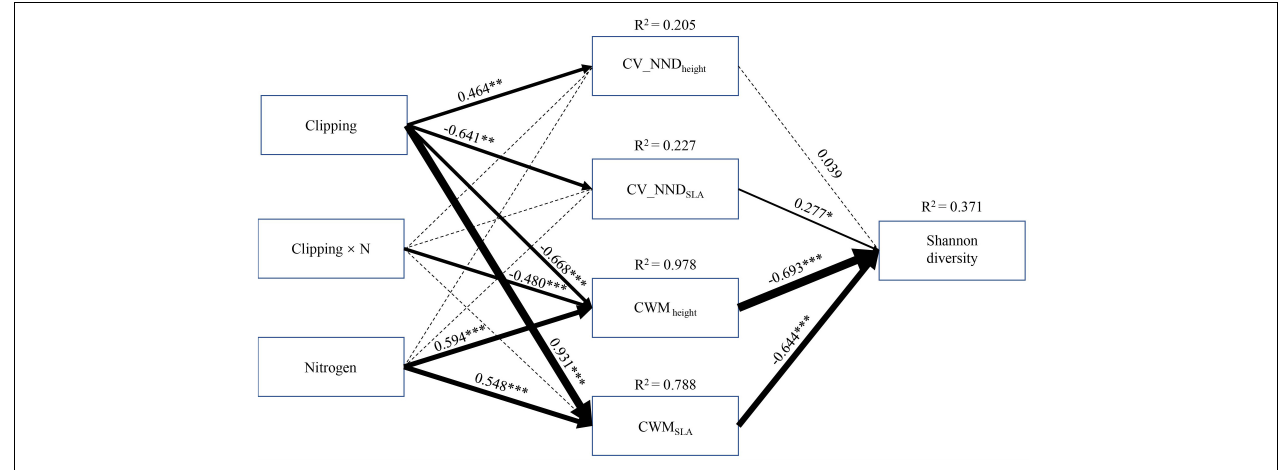
FIGURE 5 | Structural equation modeling of the clipping by nitrogen addition effects on the Shannon diversity of plant community. For abbreviations see Figures 3 , 4 . df = 19, P (Chi-square) = 0.078, CFI = 0.980, P (RMSEA) = 0.141. Black solid arrows indicate a significant effect (at the level P < 0.05), and black dashed arrows indicate non-significant effect (at the level P > 0.05). Values associated with solid arrows represent standardized path coefficients, which are also indicated by arrow width. R 2 values associated with response variables indicate the proportion of explained variation by relationship with other variables. Black solid arrows indicate a significant effect (at the level ∗ P < 0.05, ∗∗ P < 0.01, ∗∗∗ P <